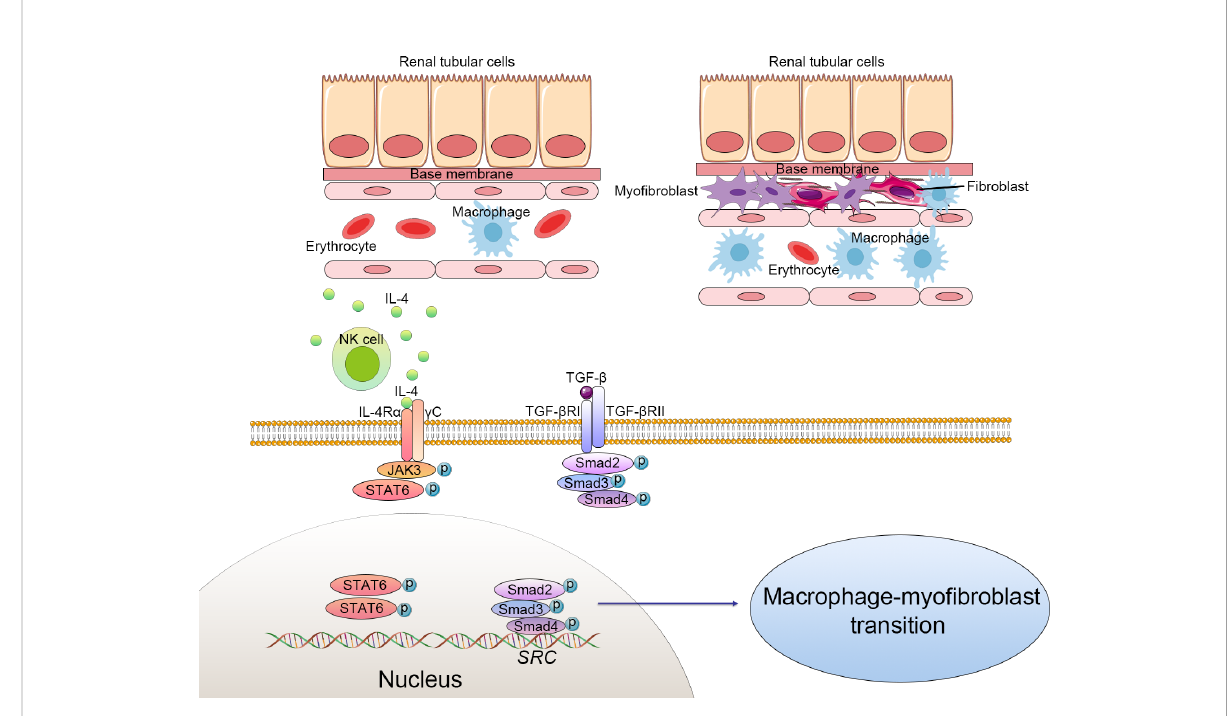
FIGURE 1 Cellular alteration and signaling pathway of macrophage-to-myo fi broblast transition (MMT) in renal fi brosis. The macrophages derived from bone marrow differentiate to myo fi broblasts, which produce excessive extracellular matrix and progressively cause structural and functional impairment of the kidney. Macrophage-to-myo fi broblast transition plays a crucial role in renal fi brosis through multiple mechanisms, including triggering the transforming growth factor- b 1 (TGF- b 1)/Smad3 signaling pathways and natural killer T cells (NKT)/IL-4 signaling pathways. Activated NKT cells produce excessive IL-4, which subsequently combines with IL-4 receptor a and triggers the JAK3/STAT6 signaling to enhance the transformation of myo fi broblasts. TGF- b binds to the TGF- b receptor complex and then phosphorylates the Smad family complex and fi nally activates the Src-centric gene network in bone marrow-derived macrophages to promote the MMT process.